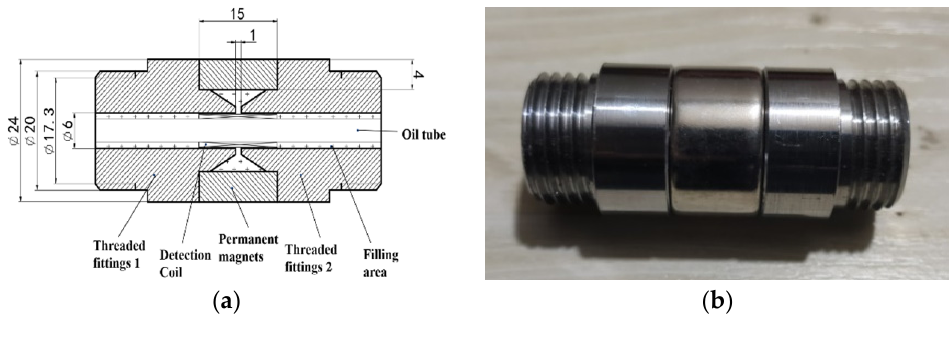
Figure 1. Structure of sensor: ( a ) structure, ( b ) sensor.